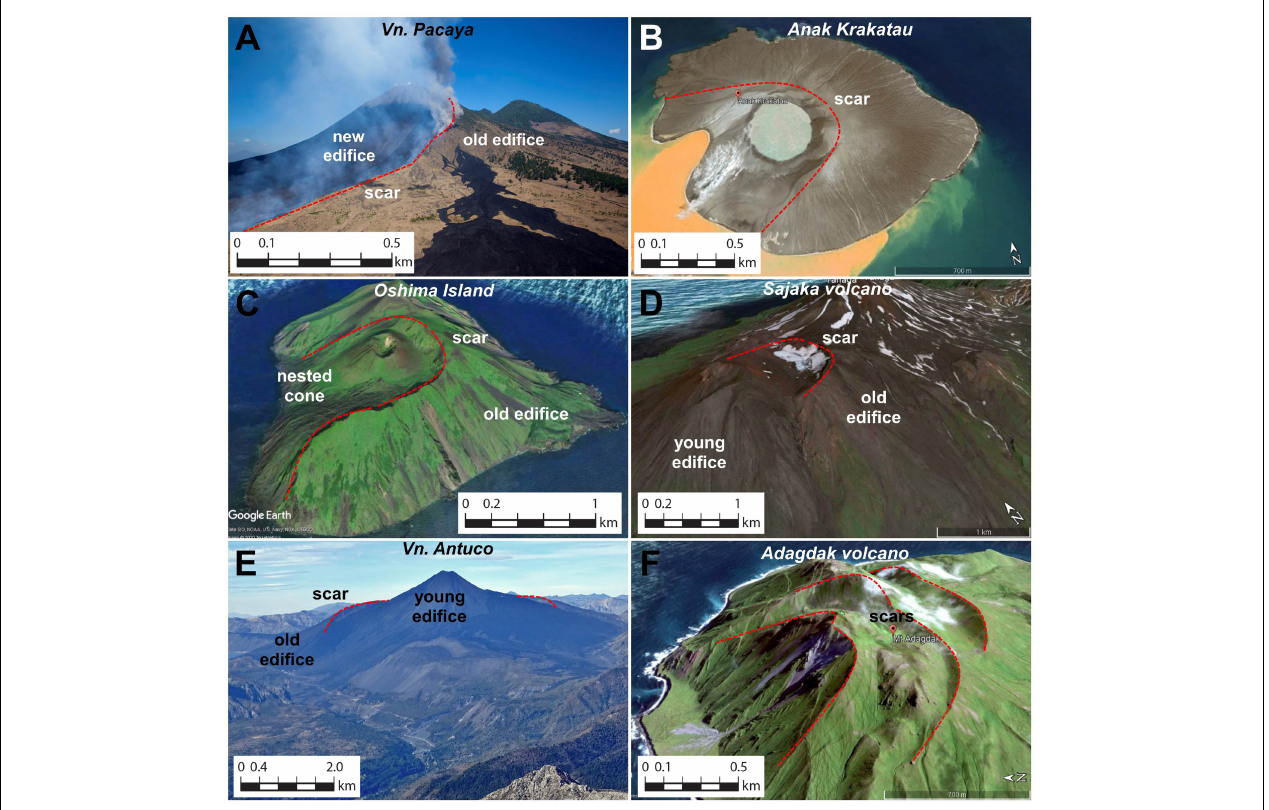
FIGURE 8 | Morphological features related to sector collapses in basaltic volcanoes (A) Pacaya volcano (Guatemala); (B) Anak Krakatau (Indonesia); (C) Oshima-Oshima volcano (Japan); (D) Sakaja volcano (Aleutians); (E) Antuco volcano (Chile), and (F) Adagdak volcano (Aleutians) with multiple collapse scars. Individual authors of selected field photos are indicated in the figure. Red dashed lines show the scar of these collapses. Photo (A) by CONRED, and (E) by Constanza Jorquera. (B – D,F) image source is Google Earth.